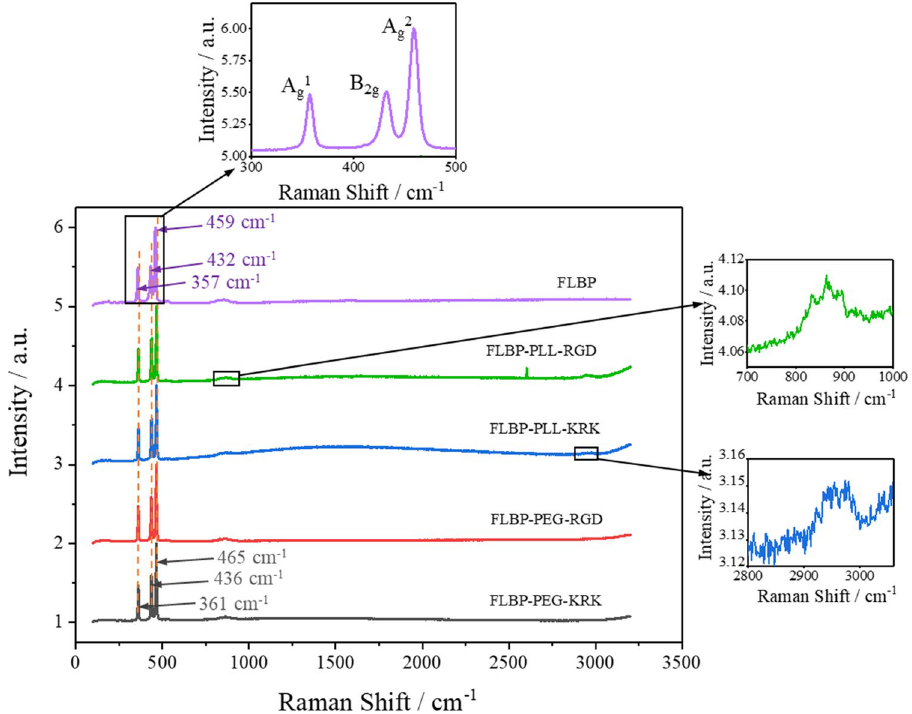
Figure 11. Raman spectra for few layer black phosphorus (FLBP) and its conjugates: FLBP-PLL-RGD, FLBP- PLL-KRK, FLBP-PEG-RGD and